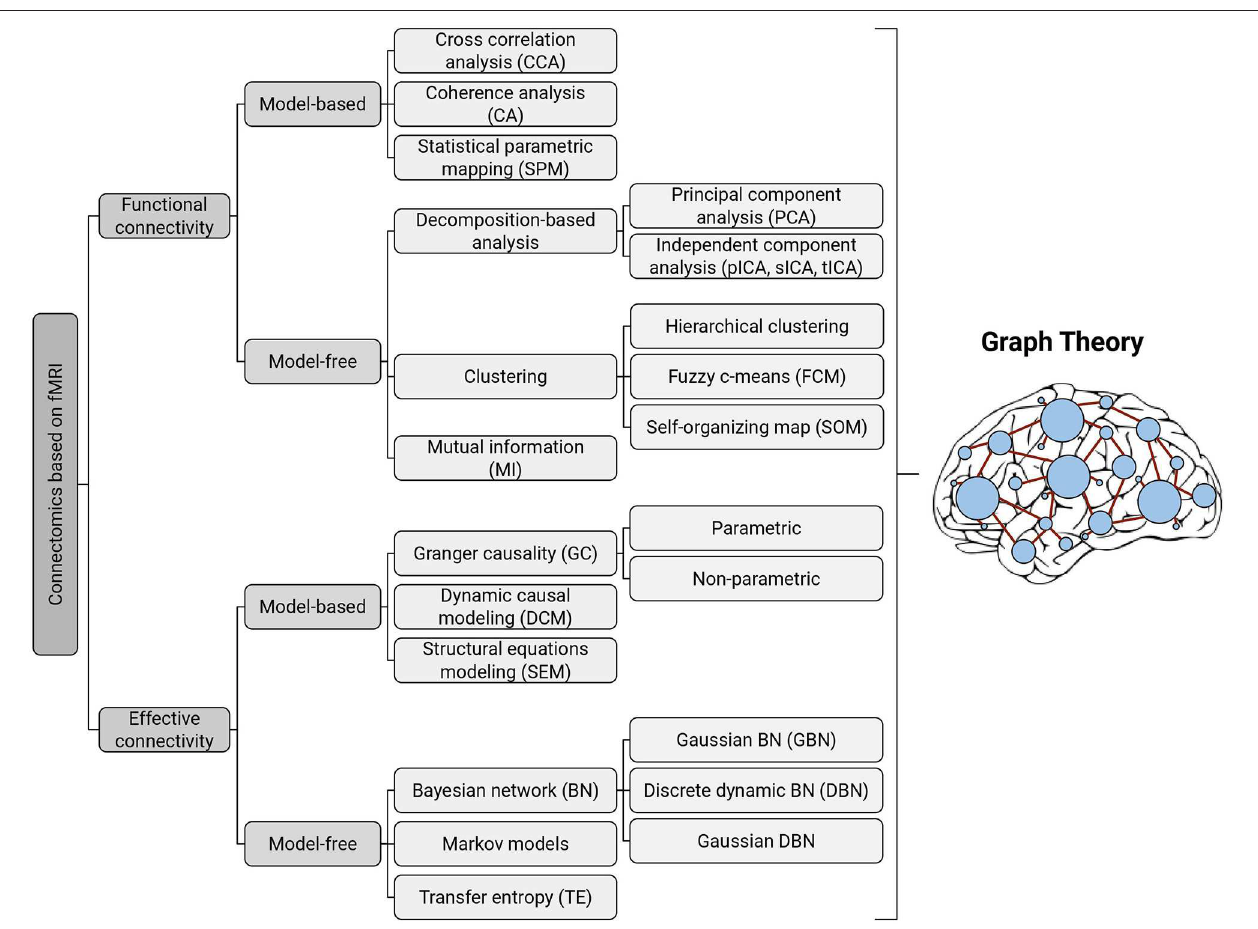
FIGURE 1 | Taxonomy of existing methods for modeling functional and effective connectivity patterns using fMRI. Each of the identified methods can be represented in terms of a graph, where the nodes correspond to cortical or subcortical regions and the edges represent (directed or undirected) connections (Bullmore and Sporns, 2012 ); thereby all of them can be further examined with graph-theoretic